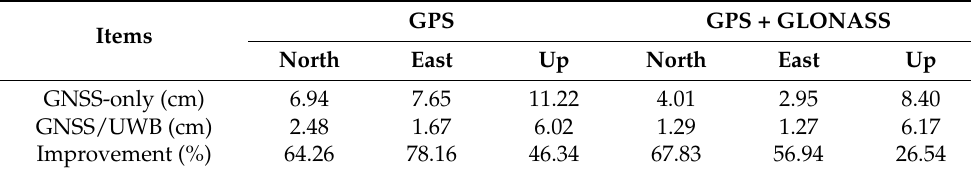
Table 1. RMS values of the positioning errors of GNSS/UWB and GNSS-only